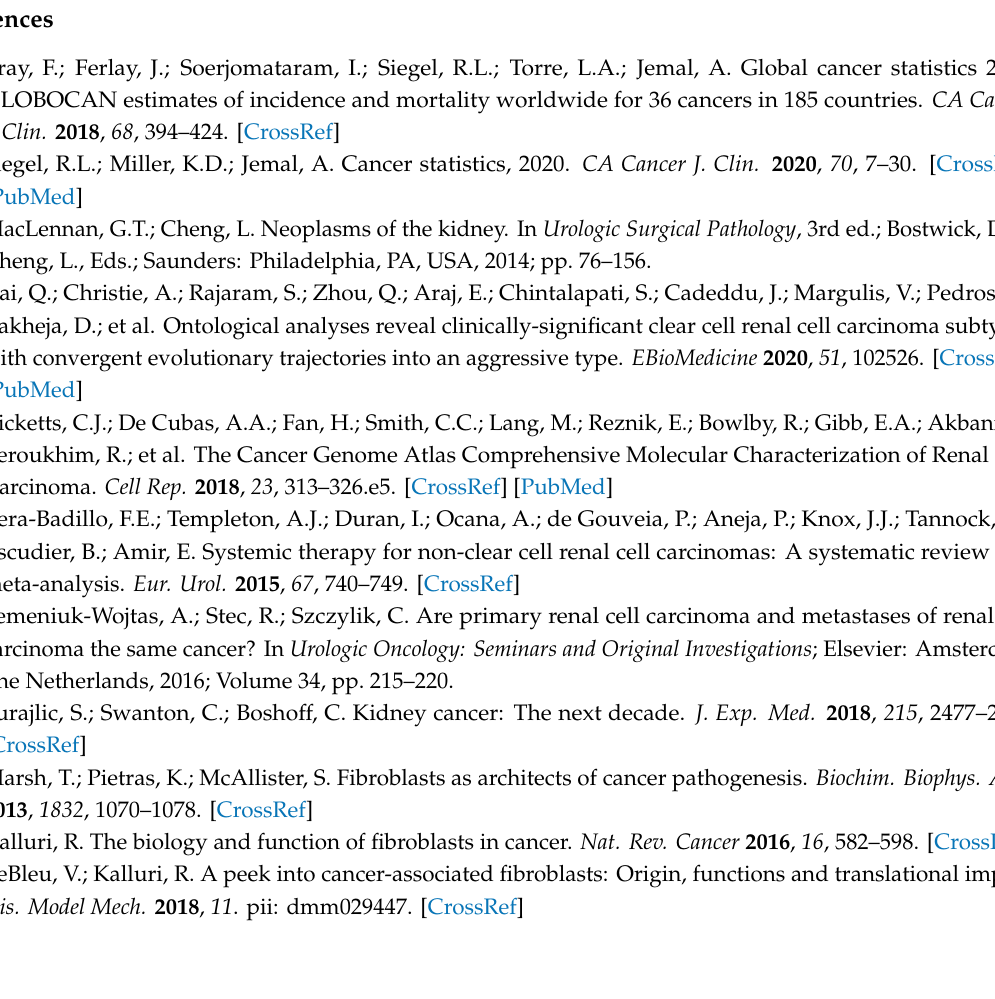
Figure S1: FAP immunostaining in centre (A) and border (B) of CCRCC tissues in terms of local invasion (pT). FAP-positive cases at the centre of the tumour were significantly higher in non-organ-confined and pT2 tumours than in pT1 ones. At the infiltrating front of these non-organ-confined tumours, FAP positive cases almost duplicated the expression of pT1 tumours, although it did not reach statistical significance, and pT2 tumours had higher FAP expression than pT1 ones. Figure S2: Classification and Regression Tree (CRT). A plasma FAP (sFAP) value of 61.03 ng / mL determined two nodes with significant di ff erences in the percentage of alive patients ( p = 0.034). Table S1: Correlation between age, sex, tissue FAP expression and soluble FAP levels in CCRCC, PRCC, ChRCC, and RO patients (Spearman Rho test). Table S2: ROC Curves. Sensitivity and specificity of tissue and plasma FAP to predict cancer-specific survival (CSS) of CCRCC patients ( n = 89). Sensitivity and specificity of tissue FAP to determine the potential of FAP staining in tumour tissues for the di ff erential diagnosis between ChRCC ( n = 8) and RO ( n = 10). AUC : Area Under the